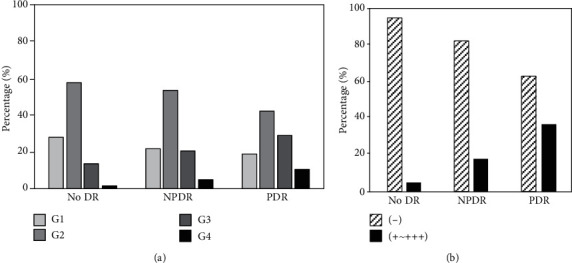
Prevalent diabetic retinopathy and renal function. (a) eGFR category: G1 (≥90), G2 (60–89), G3 (30–59), and G4 (15–29 ml/min/1.73m2) and (b) albuminuria. Abbreviation: eGFR: estimated glomerular filtration rate.